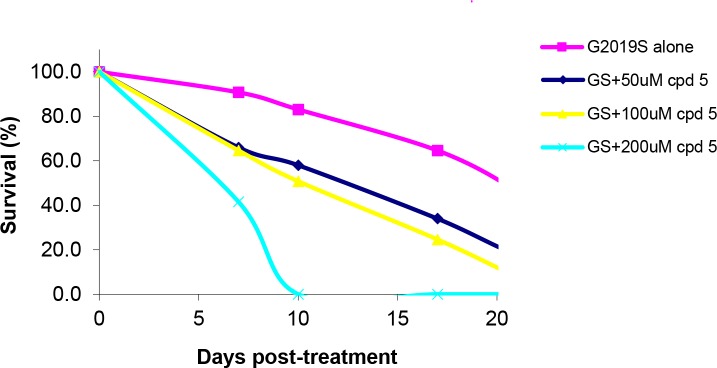
Survival percentages of mutant LRRK2 G2019S flies after 7 days, 10 days and 17 days of treatment with various concentrations (50 μM, 100 μM, 200 μM) of compound 5.